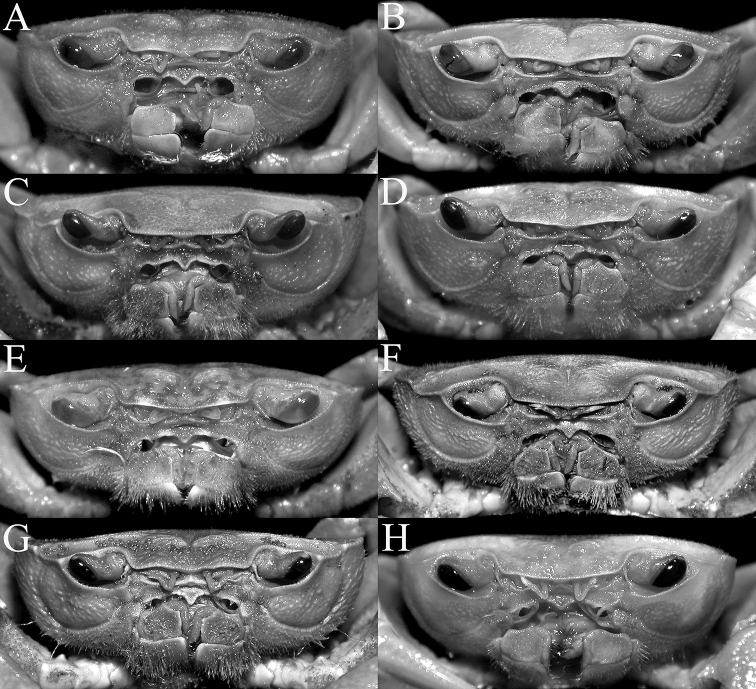
Frontal view of cephalothorax AJohora
intermedia Ng, 1986, holotype male (19.8 × 15.1 mm) (ZRC 1984.6529), Pahang BJ.
tahanensis (Bott, 1966), male (30.7 × 25.5 mm) (ZRC 1984.6795), Pahang CJ.
thoi Ng, 1990, holotype male (41.2 × 33.3 mm) (ZRC 1989.2249), Terengganu DJ.
hoiseni Ng & Takeda, 1992, holotype male (25.1 × 21.1 mm) (ZRC 1984.6673), Kelantan EJ.
thaiana Leelawathanagoon, Lheknim & Ng, 2005, paratype male (22.2 × 18.6 mm) (ZRC 2006.0052), Thailand FJ.
booliati sp. nov., holotype male (34.6 × 30.0 mm) (ZRC 2020.0072), Pahang GJ.
erici sp. nov., holotype male (38.3 × 32.0 mm) (ZRC 2020.0360), Perak HJ.
michaeli sp. nov., holotype male (22.7 × 19.2 mm) (ZRC 2010.0047), Terengganu.